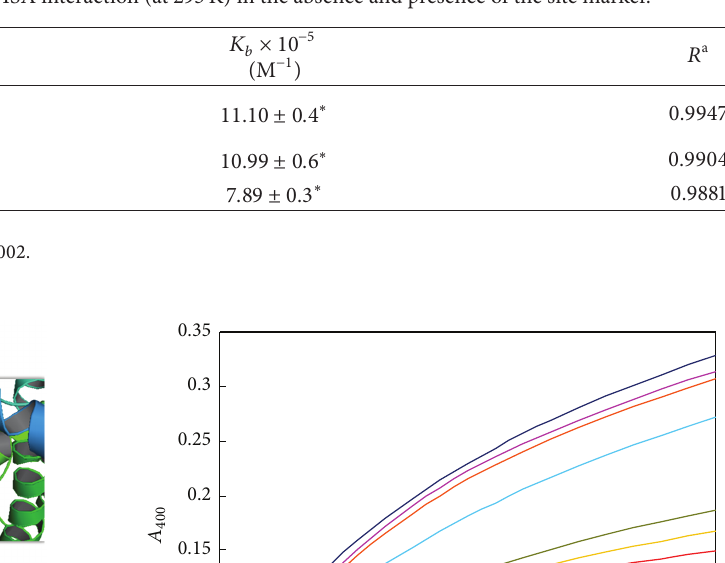
Table 4: Binding constants for isoimperatorin-HSA interaction (at 295 K) in the absence and presence of the site marker.